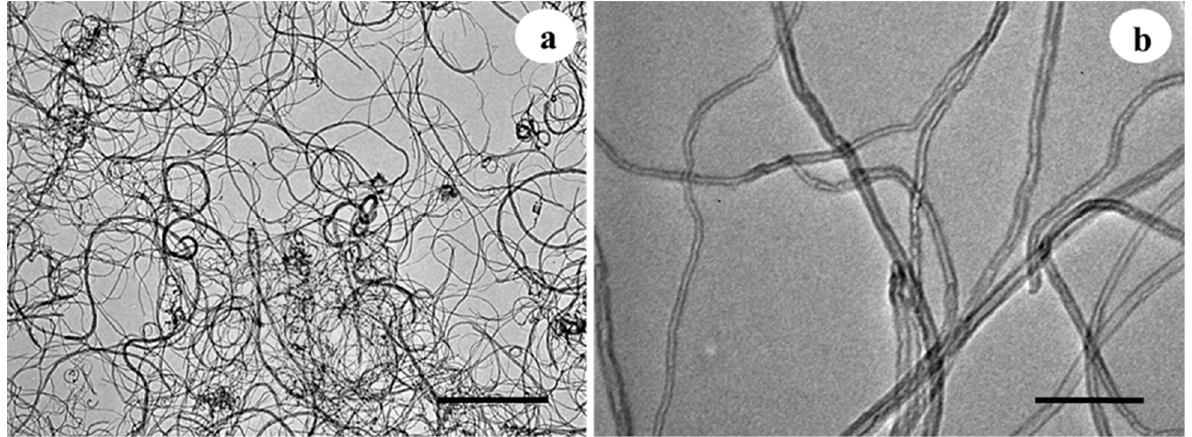
Figure 1. Multi-walled carbon nanotubes (MWCNTs) observed by transmission electron microscopy (TEM) using different magnifications. ( a ) Black bar = 1000 nm. ( b ) Black bar = 100 nm.